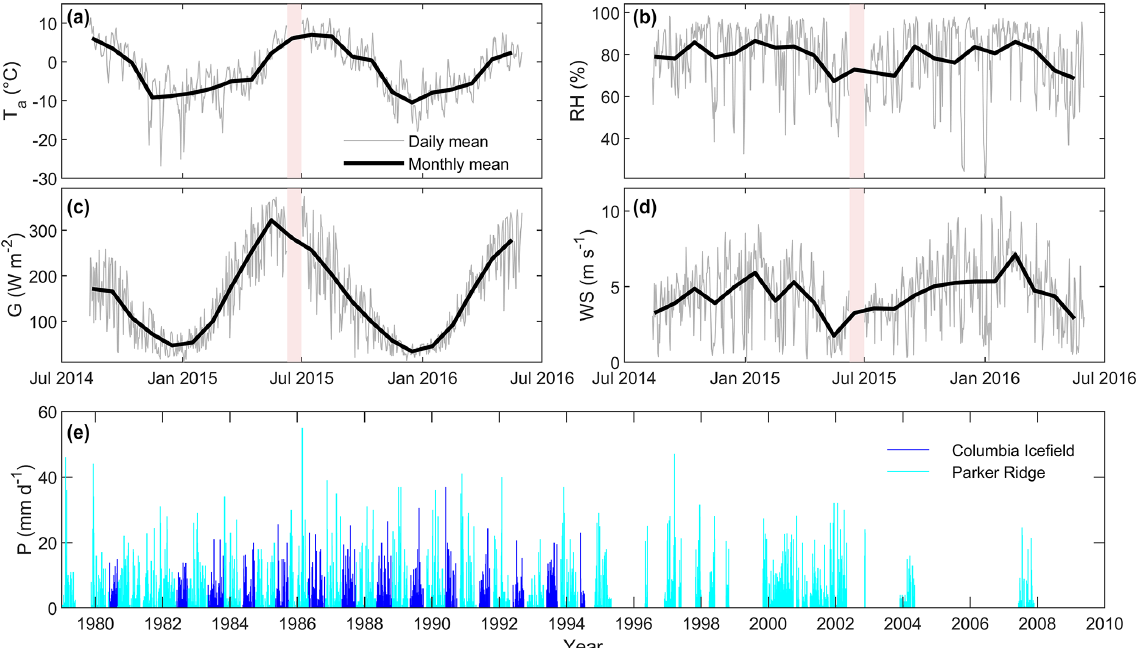
Figure 2. A 2-year record from the Saskatchewan Glacier AWS (2014–2016). (a) Air temperature ( T a ); (b) relative humidity (RH); (c) in- coming global solar radiation ( G ); (d) wind speed (WS). Pink shades delineate the data gap caused by the fall of the AWS (11 to 30 June 2015). (e) Daily precipitation records from the Parker Ridge and Columbia Icefield permanent stations. Note the several gaps after 1995 when the Columbia Icefield station was